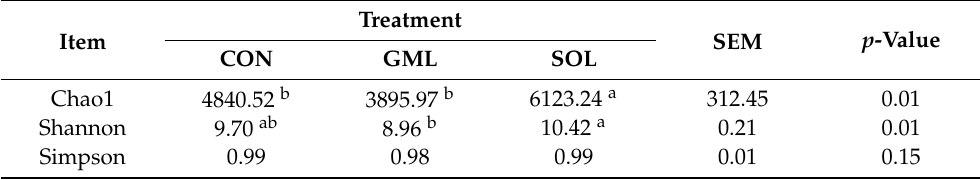
Table 4. Effects of monoglyceride laurate and Solider on community richness and diversity indexes.